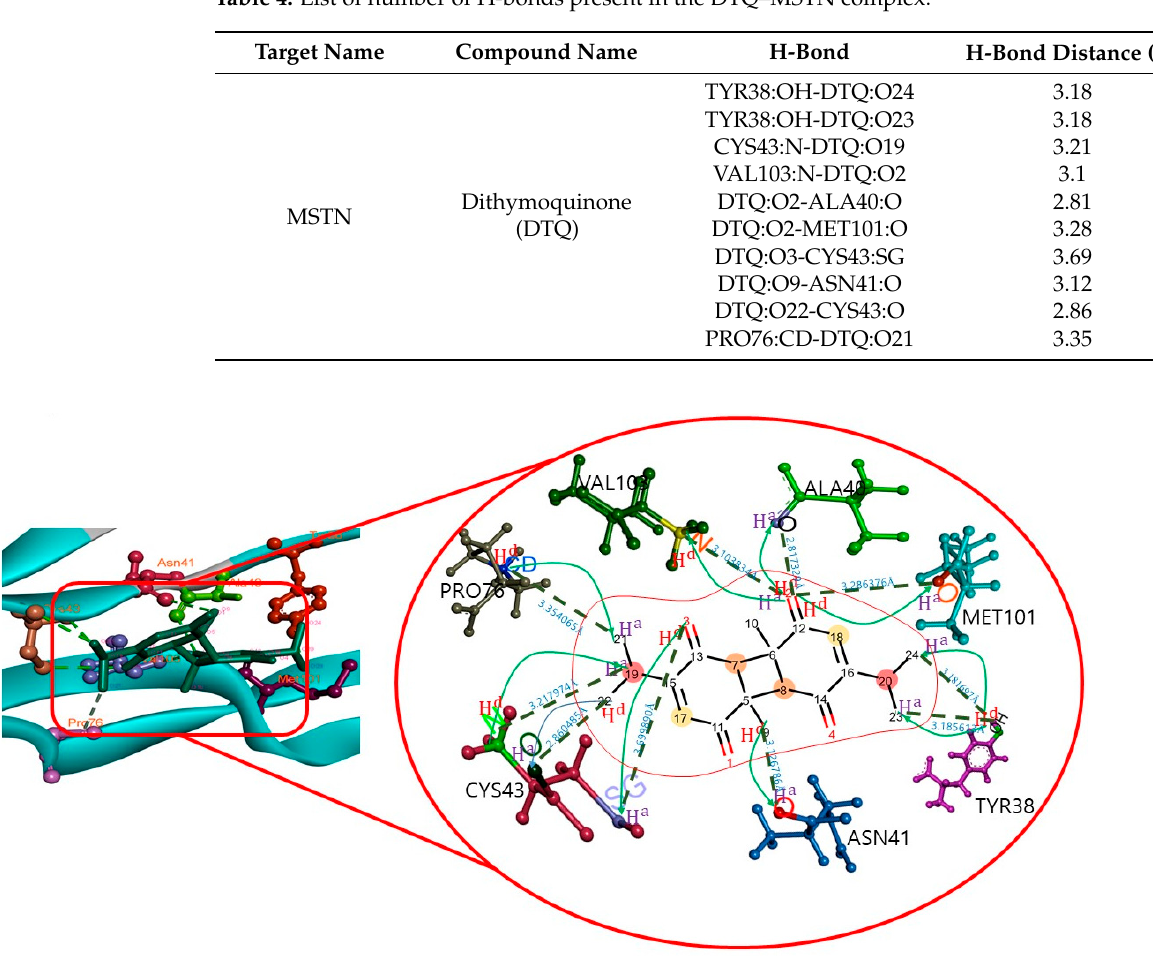
Figure 1. Atomic level interaction between MSTN and DTQ determined by docking. Furthermore, residues LEU20, VAL22, TYR42, and VAL102 were involved in hydro- phobic interactions. In this complex, DTQ was shown to interact with the different amino